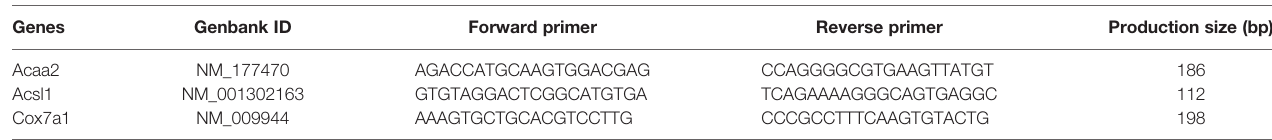
TABLE 2 | Primers for